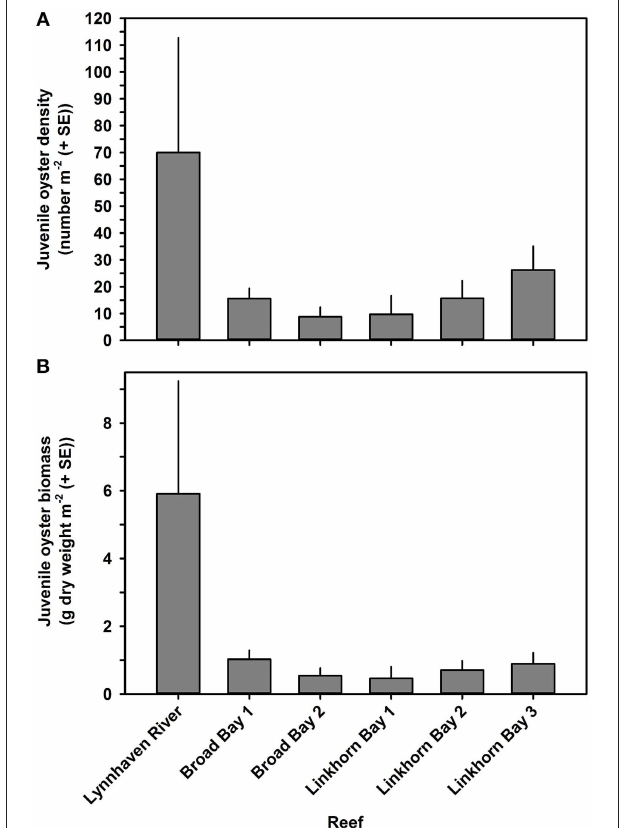
FIGURE 8 | Juvenile oyster density (A) and biomass (B) on constructed oyster reefs in the Lynnhaven River (Eastern Branch), Broad Bay, and Linkhorn Bay. Bars represent 1 standard error of the